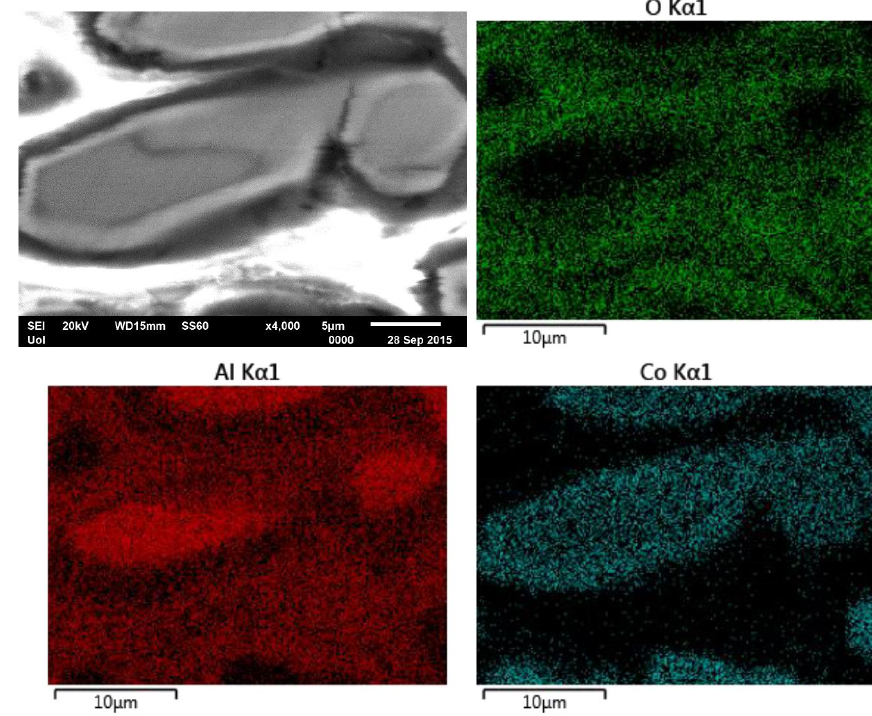
Figure 10. Cross‐section (SE mode) of Al‐20 wt.% Co after cyclic polarization (3.5 wt.% NaCl, 25 °C) and EDX elemental mapping.